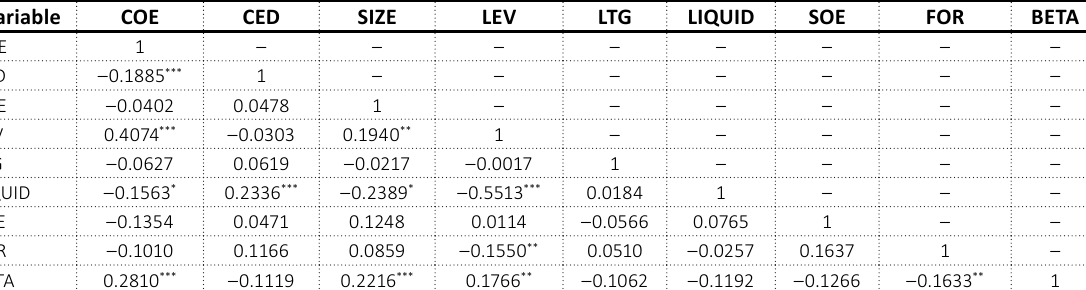
Table 5. Correlation